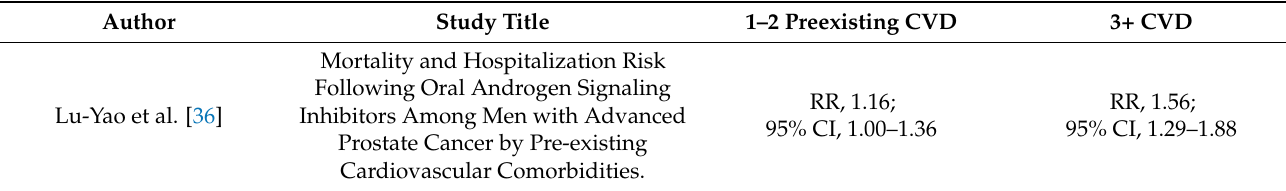
Table A5. Risk of CV Mortality in Patients on Abiraterone or